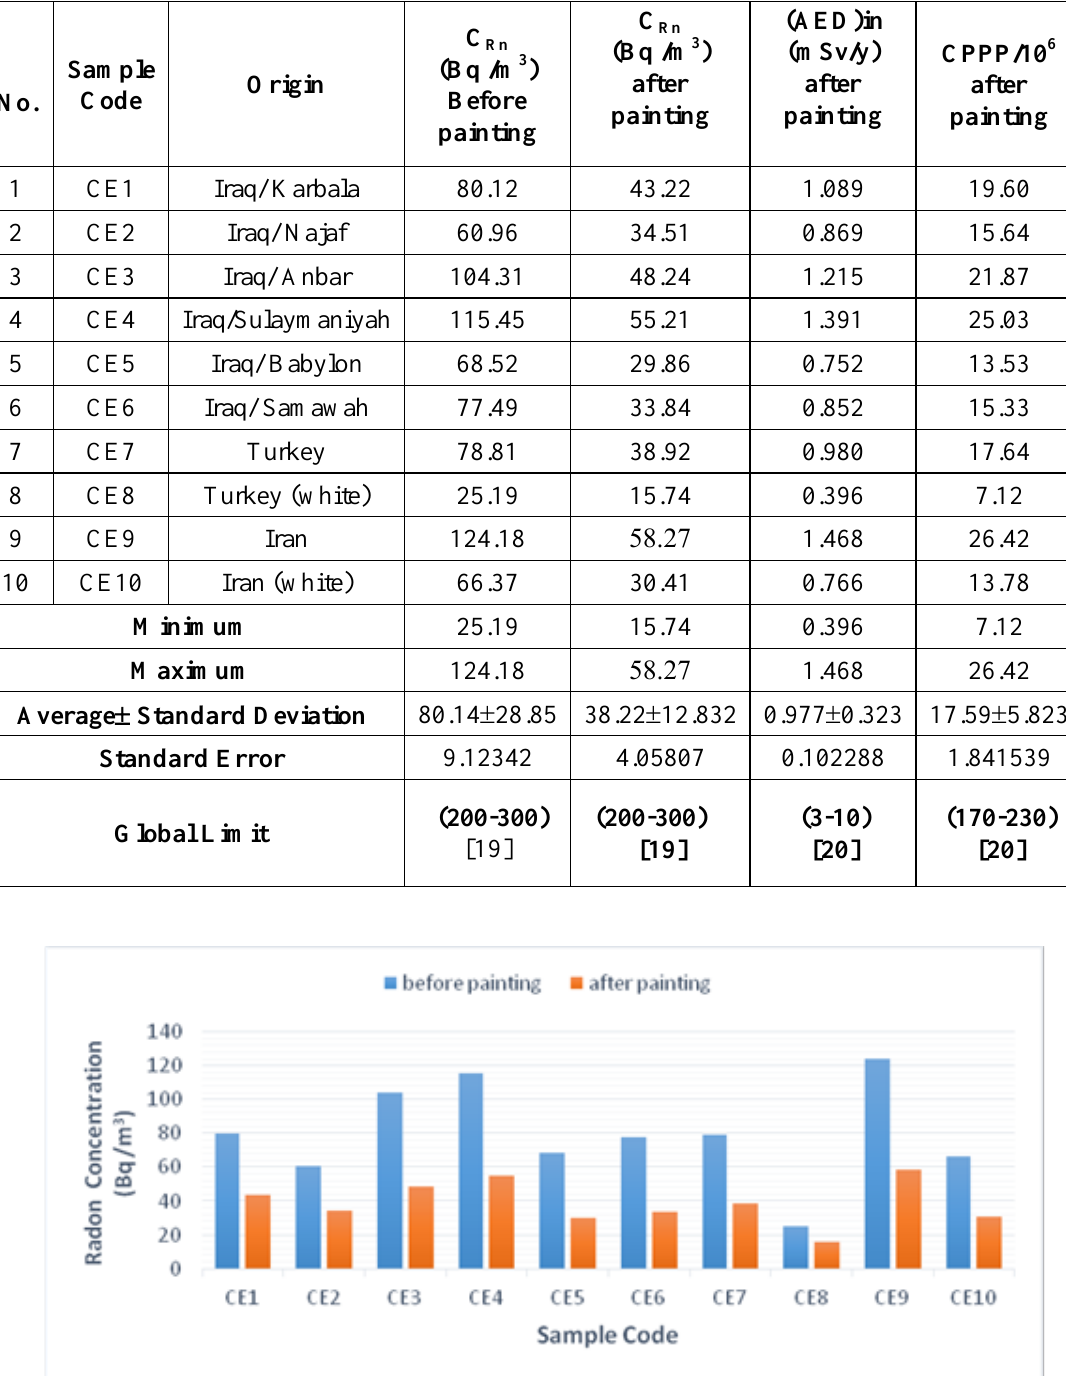
) Before and after painting, (AED), (CPPP). Rn